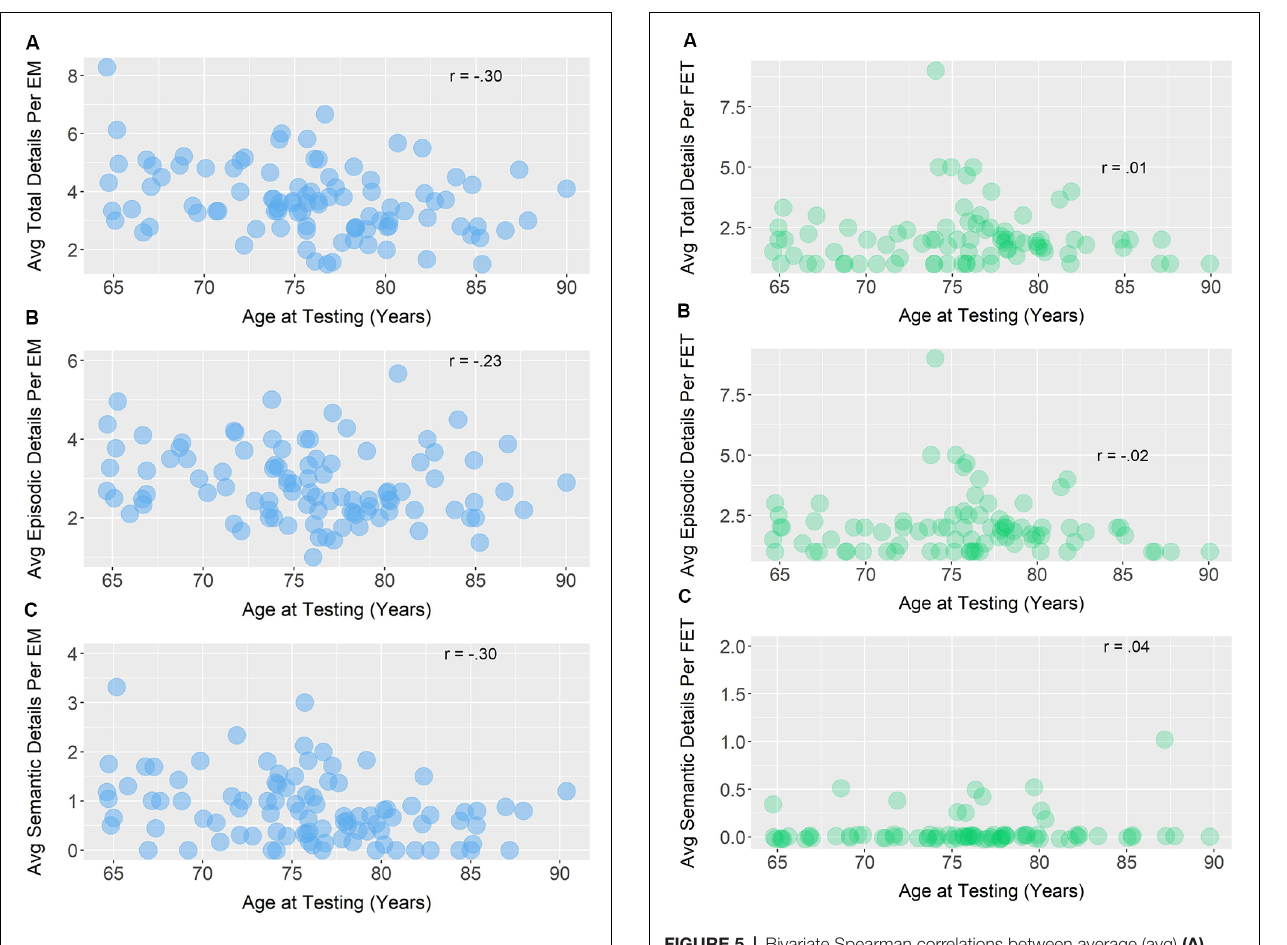
FIGURE 4 | Bivariate Spearman correlations between average (avg) (A) total, (B) episodic, and (C) semantic details produced in sound files containing autobiographical episodic memories (EM) and age.